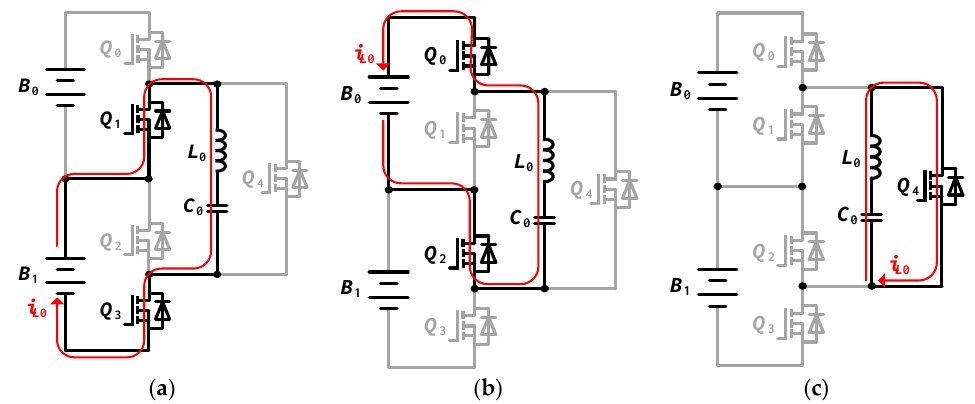
Figure 6. Operating states of the proposed equalizer at V B 0 < V B 1 . ( a ) charge state; ( b ) discharge state; ( c ) release state. Energies 2017 , 10 , 206